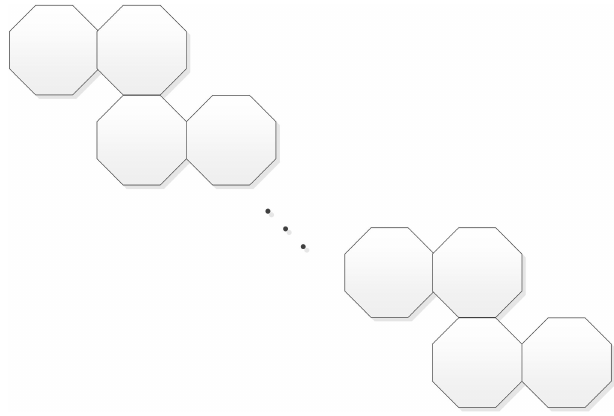
Fig. 2 The zig-zag chain of